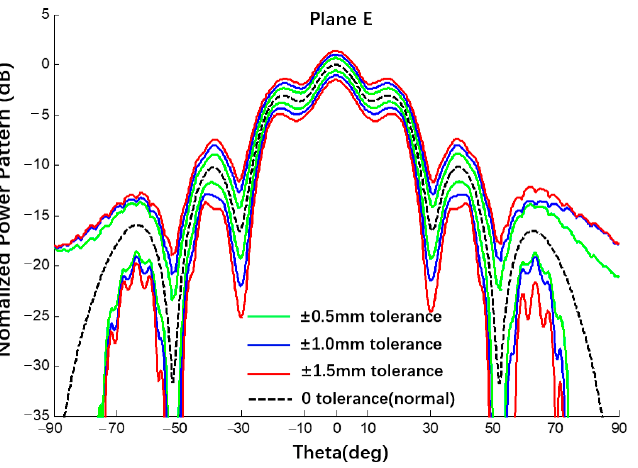
Sensors 2022 , 22 , x FOR PEER REVIEW